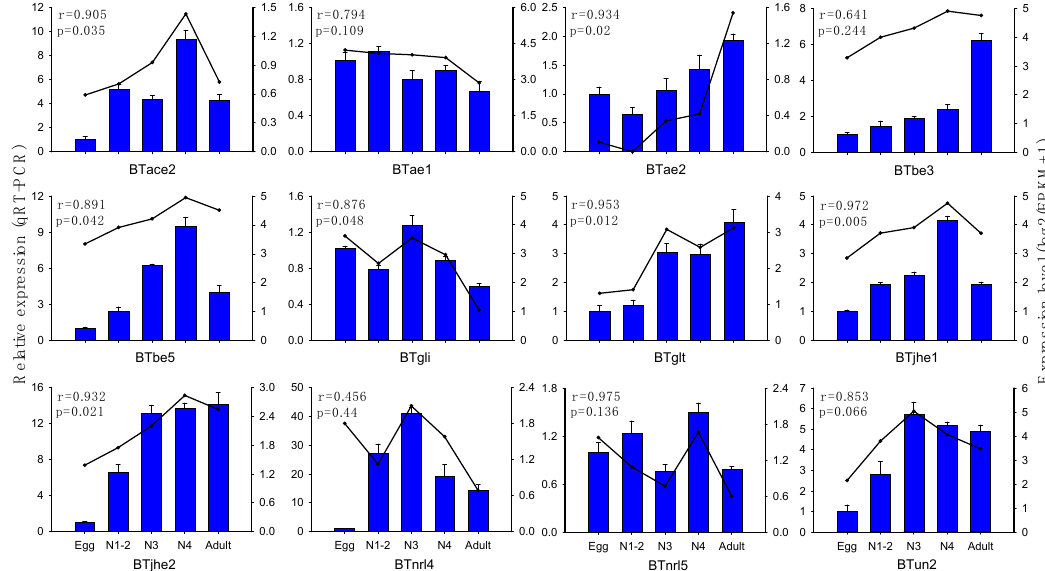
Figure 3. qRT-PCR-based expression profiling of COE genes at different stages of B. tabaci MED development. Total RNA was extracted during individual developmental stages of B. tabaci MED and used to analyze the expression levels of COEs with qRT-PCR. FPKM values were used to determine the transcript levels of COEs with RNA-seq, and the results are expressed in the form of log2(FPKM+1). Correlation between RNA-seq and qRT-PCR were tested using SPSS 23 with Pearson and two-tailed test, r, Pearson correlation; p , significant. E, Egg; N1-2, 1st- and 2nd-instar nymphs; N3, 3rd-instar nymph; N4, 4th-instar nymph; A, Adult.